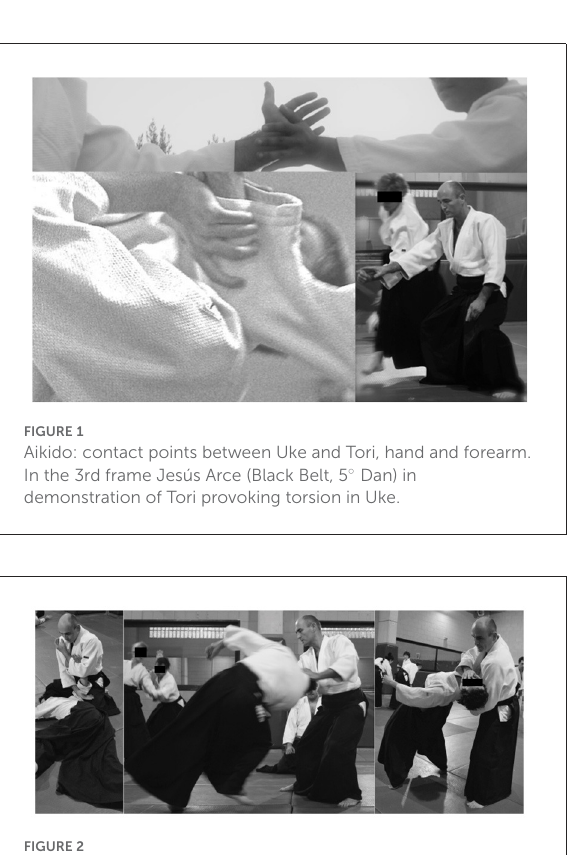
FIGURE2 Aikido: Tori performing techniques on Uke through basically immobilizing, projections or combinations of both. Jesús Arce (Black Belt, 5 ◦ Dan) in